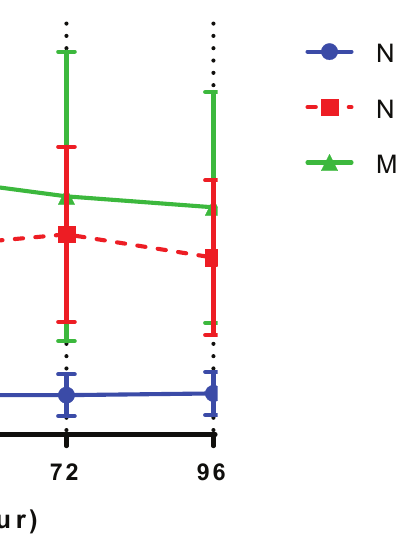
Figure 2: Dynamic changes of serum neopterin level in patients of different groups.